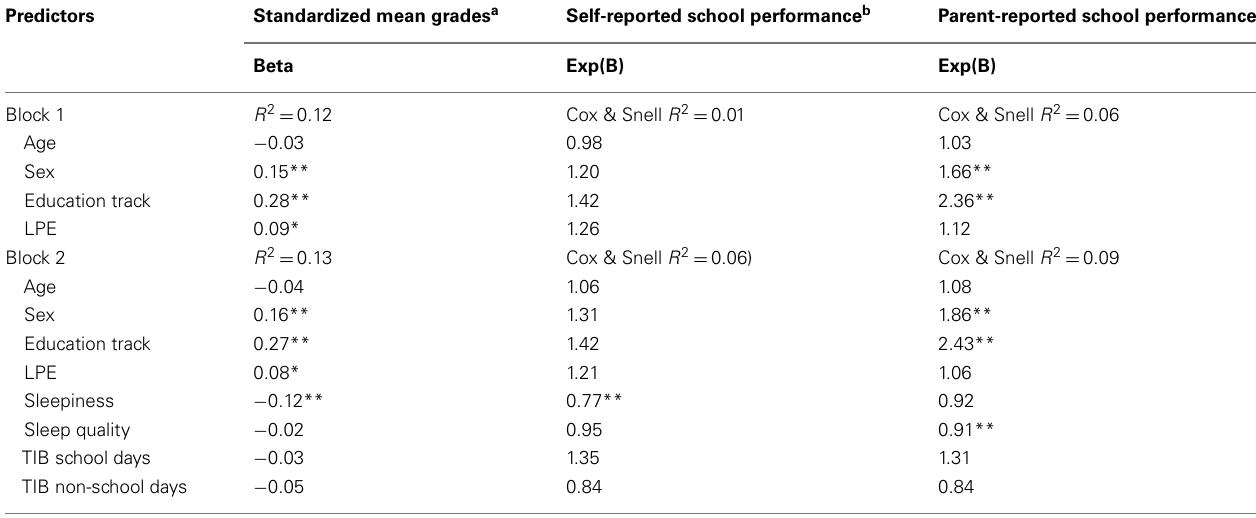
Table 2 | Relations between sleep and school performance measures: results of linear and logistic regression analyses.